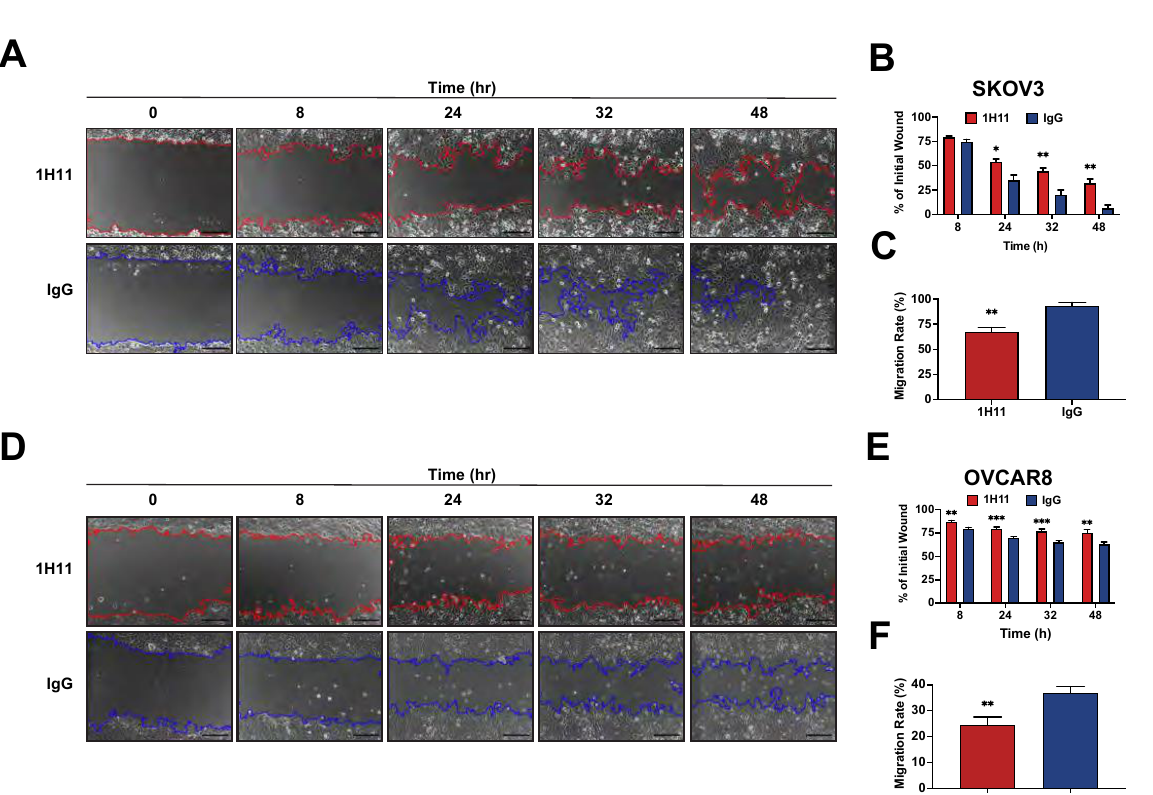
Figure 4. 1H11 inhibits OC cell migration. A scratch assay was used to evaluate the migration ability of cells treated with 2 µM 1H11 or IgG. Wounds inflicted on ( A ) SKOV3 and ( D ) OVCAR8 were imaged for up to 48 h. Representative images are shown with a scale bar = 200 µm. ( B,E ) Quantification of wound closure demonstrates that 1H11 inhibited cell motility. Similarly, treatment with 1H11 significantly reduced the migration rate of ( C ) SKOV3 and ( F ) OVCAR8. All data plotted as mean ± SEM. *** p < 0.001, ** p < 0.01, * p < 0.05 vs. IgG.